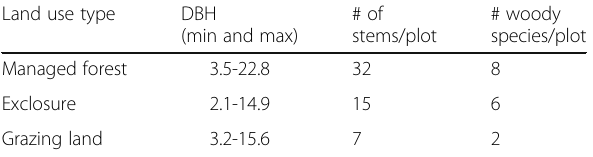
Table 4 Rang of tree diameters at breast height (DBH in cm) and average number of stems under different land use types across Gergera watershed,